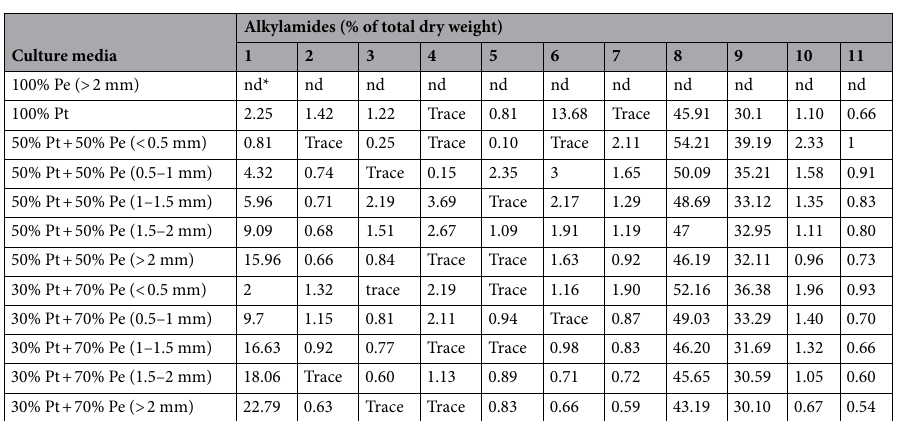
Table 3. Alkylamides percentage of E. purpurea grown at different culture media and 90:10 NO 3 − /NH 4 + ratio.